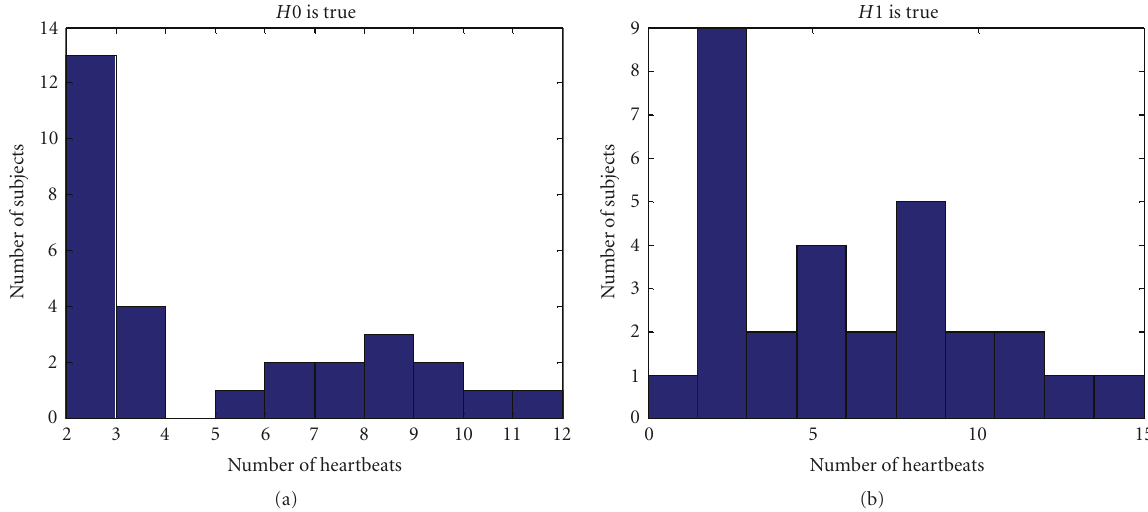
Figure 11: Histograms showing the number of heartbeats needed to reach a decision where the acceptable level of error is α = β = 0 . 01. Table 1: Summary statistics for the number of heartbeats needed to reach a decision for varying levels of the acceptable error. H 0 is true H 1 is true Allowable error ( α , β )